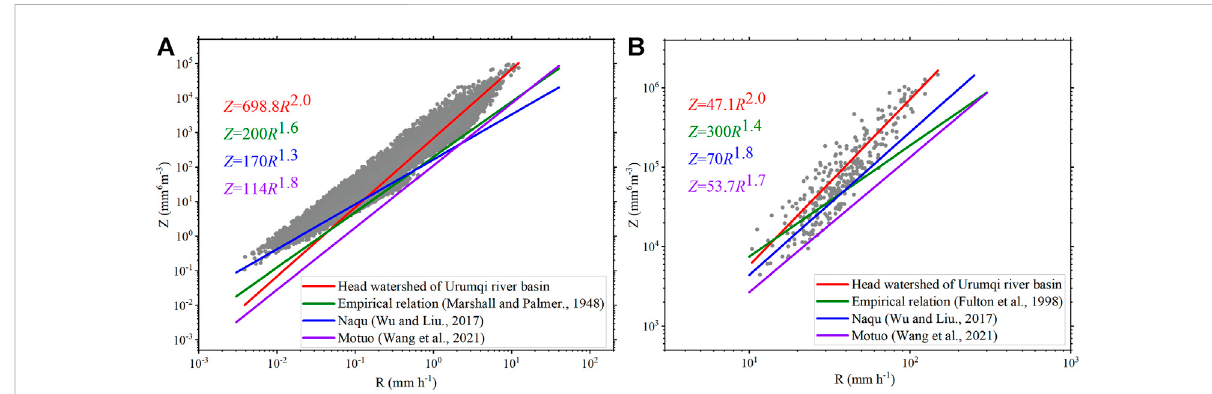
FIGURE 10 Z-R relation scatterplots for (A) stratiform and (B) convective precipitation. The solid red lines indicate the fi tting power-law relationships in the headwatershedoftheUrumqiRiverusingtheleast-squares method.Thesolidgreenlinesindicatetheempiricalrelations( Z=200R 1.60 forstratiform precipitation and Z = 300R 1.40 for convective precipitation). The solid blue lines indicate the fi tting power-law relationships in Naqu , as reported by Wu and Liu (2017). The solid purple lines indicate the fi tting power-law relationships in Motuo , as reported by Wang et al.